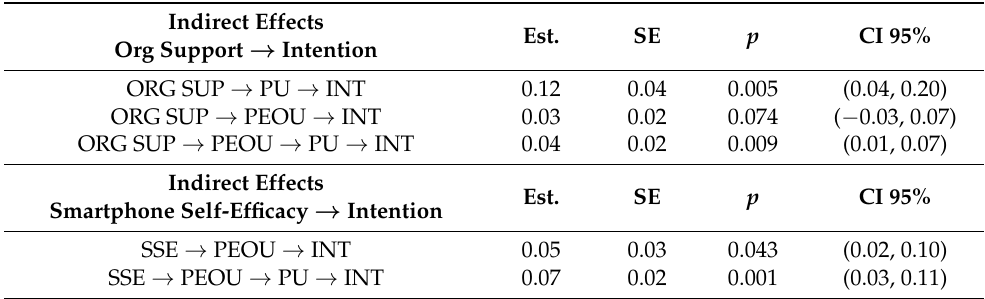
Table 3. Bootstrapping indirect